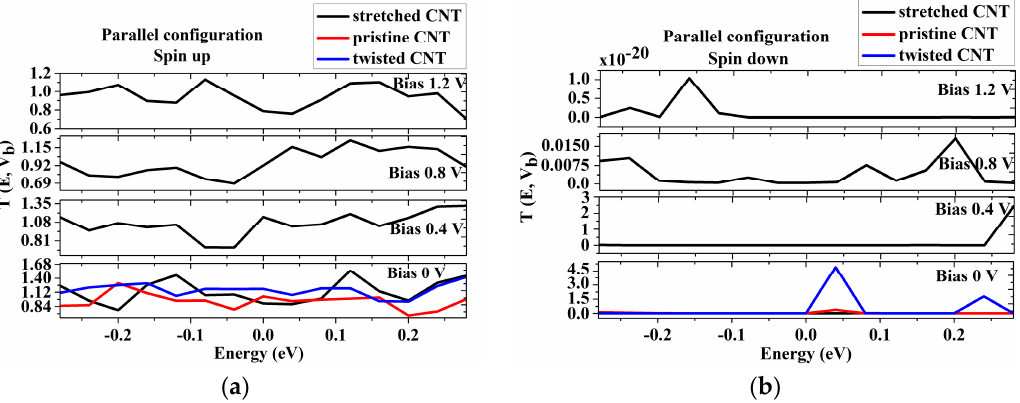
Figure 6. Transmission spectrum T (E, V b ) with respect to energy ranging from − 0.3 eV to +0.3 eV for different applied voltages for PC. At zero volts, the comparative transmission probability for all three structures, shown separately for spin ‐ up ( a ) and spin ‐ down ( b ).